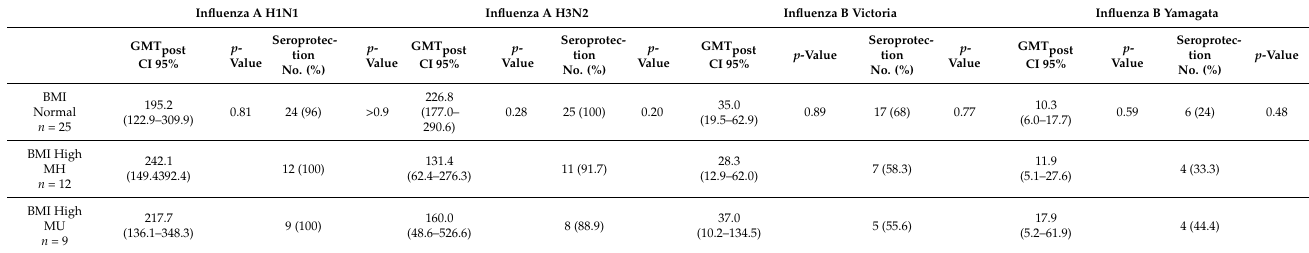
limits of the 95% confidence intervals of the log2-transformed titers. ANOVA test was performed to compare the mean differences of the GMTs within each lineage. Table 3. Antibody responses 25–42 days after vaccination against influenza A/H1N1 and H3N2 and influenza B/Victoria and Yamagata lineages according to BMI and metabolic status. A total of 46 sub- jects had serum sampled after vaccination. From these 46 subjects, 25 subjects were classified as BMI normal, 12 subjects as BMI high MH (metabolic healthy) and 9 as BMI high MU (metabolic